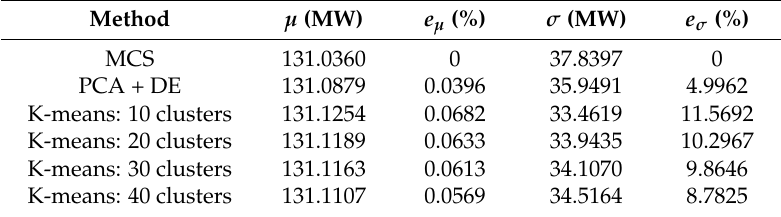
Table 2. Comparison of results from different methods for active power flow through line 30–38.